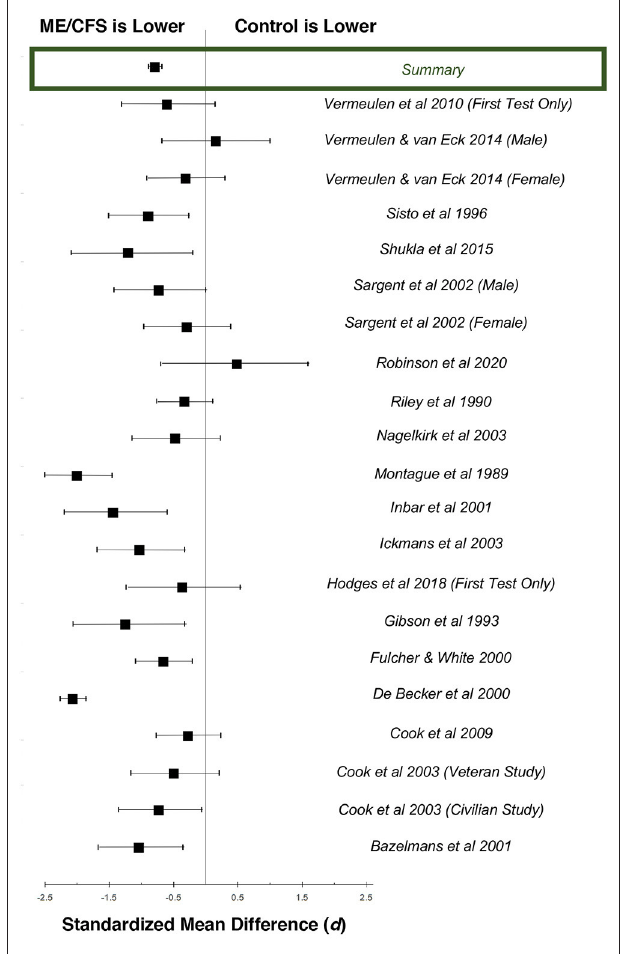
FIGURE 2 | Standardized mean differences ( d ) for heart rate at peak exertion during maximal cardiopulmonary exercise testing, comparing patients with ME/CFS ( n = 1,053) and matched control subjects ( n = 569). Boxes represent point estimates, and whiskers are 95% confidence intervals. Patients with ME/CFS had lower peak heart rates than matched control subjects (large effect